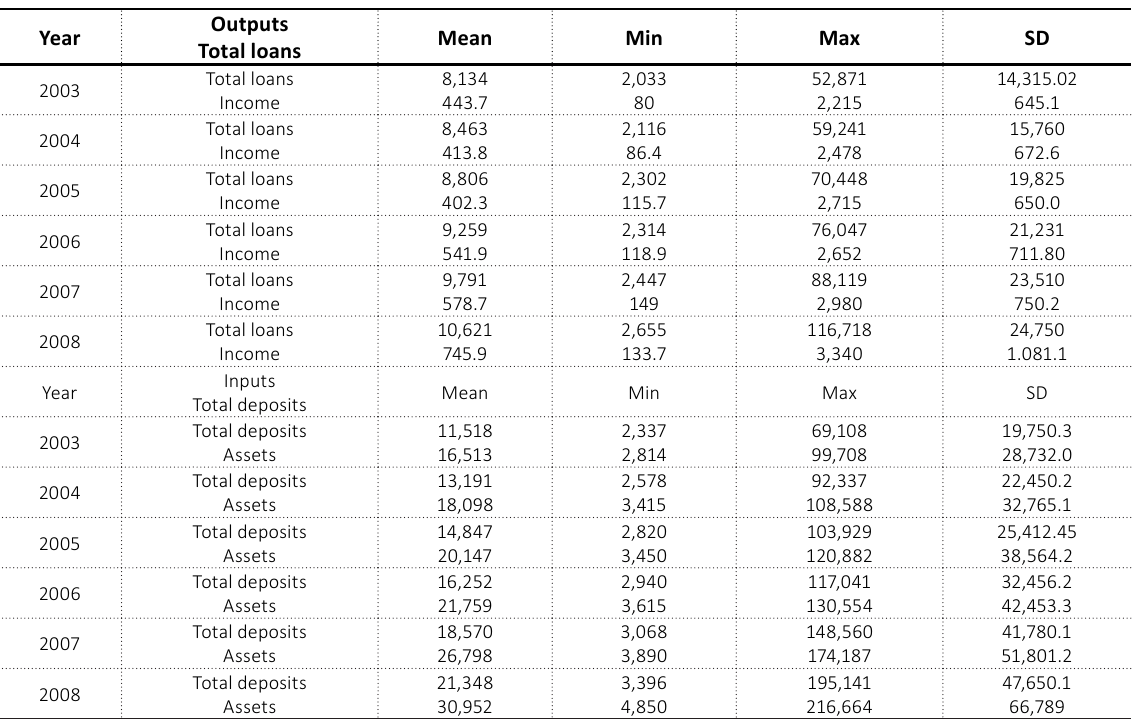
Table 2. Input and output